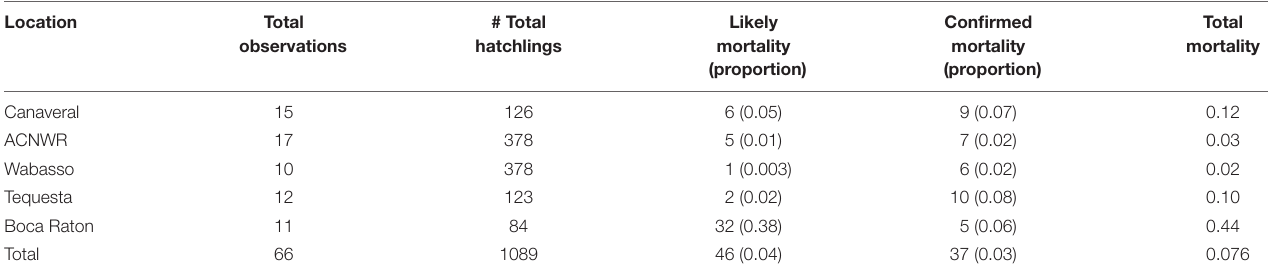
TABLE 1 | Summary of hatchling fate by location.